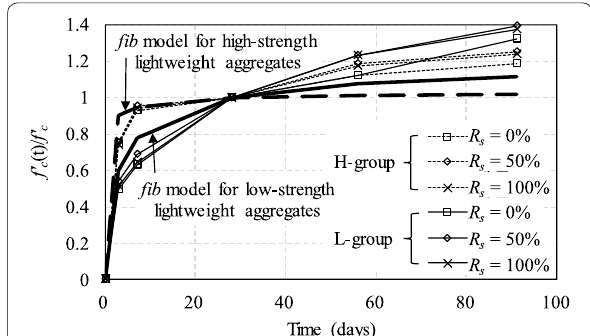
Fig. 6 Typical compressive strength development of the